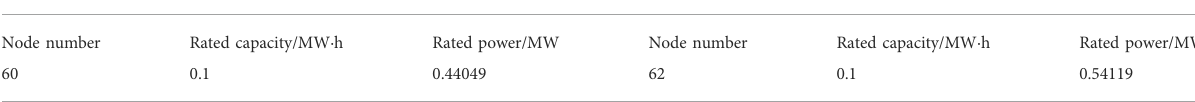
TABLE 5 BESSs optimal con fi guration scheme. BESS No.1